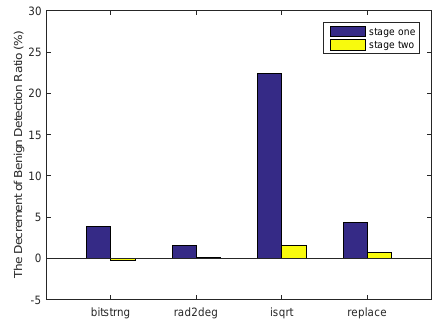
Figure 10. The decrement of benign detection